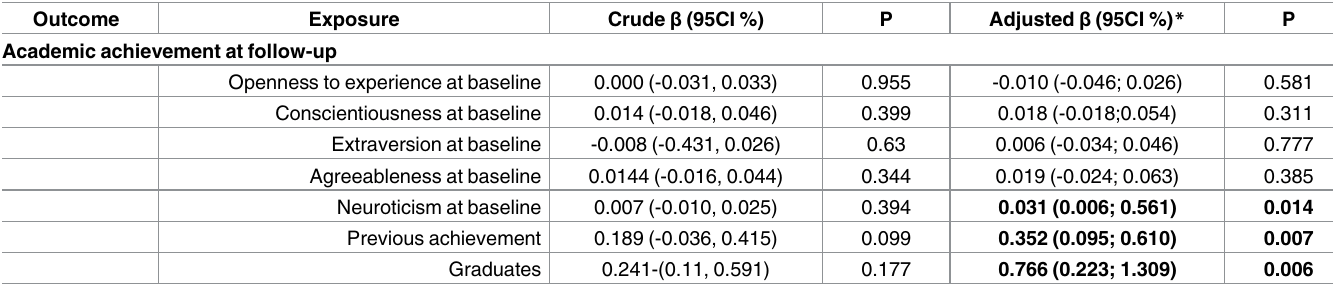
Table 3. Cross-lagged associations between academic achievement and personality traits at